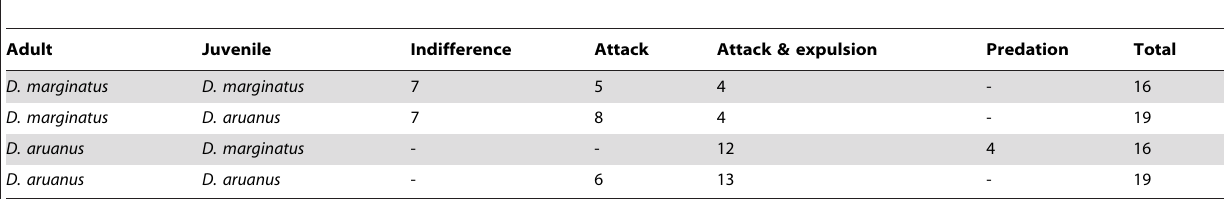
Table 4. The reaction of D. marginatus and D. aruanus adults to juveniles (a few days post-settlement) of both species that were introduced into their coral.